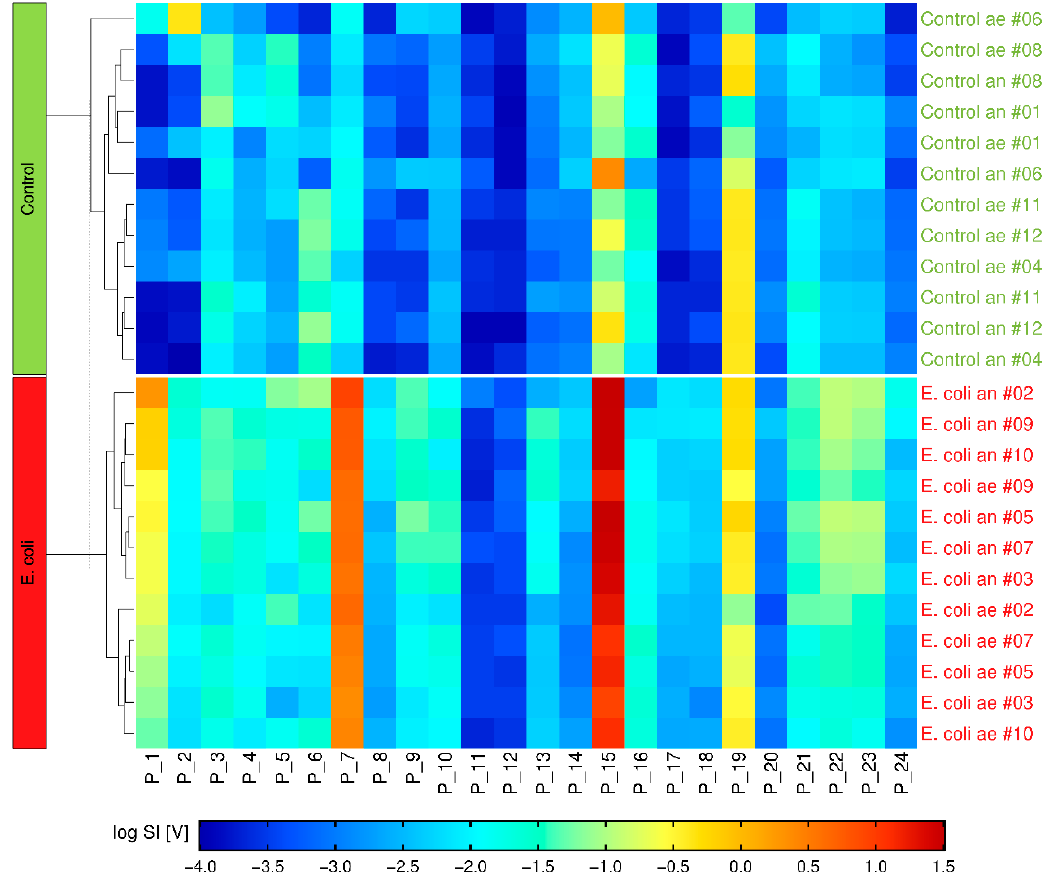
Figure 6. Heatmap of a Hierarchical-Clustering-Dendrogram after 8 h incubation time. Every row represents a single BC measurement (# = measurement ID; ae = aerobic; an = anaerobic) with the color-coded logarithmic peak SI [V] for each mVOC area. Two clusters representing Control and EC group (green and red box on the left-hand side respectively) are shown, assigning the single measurements (right) correctly to the two groups.